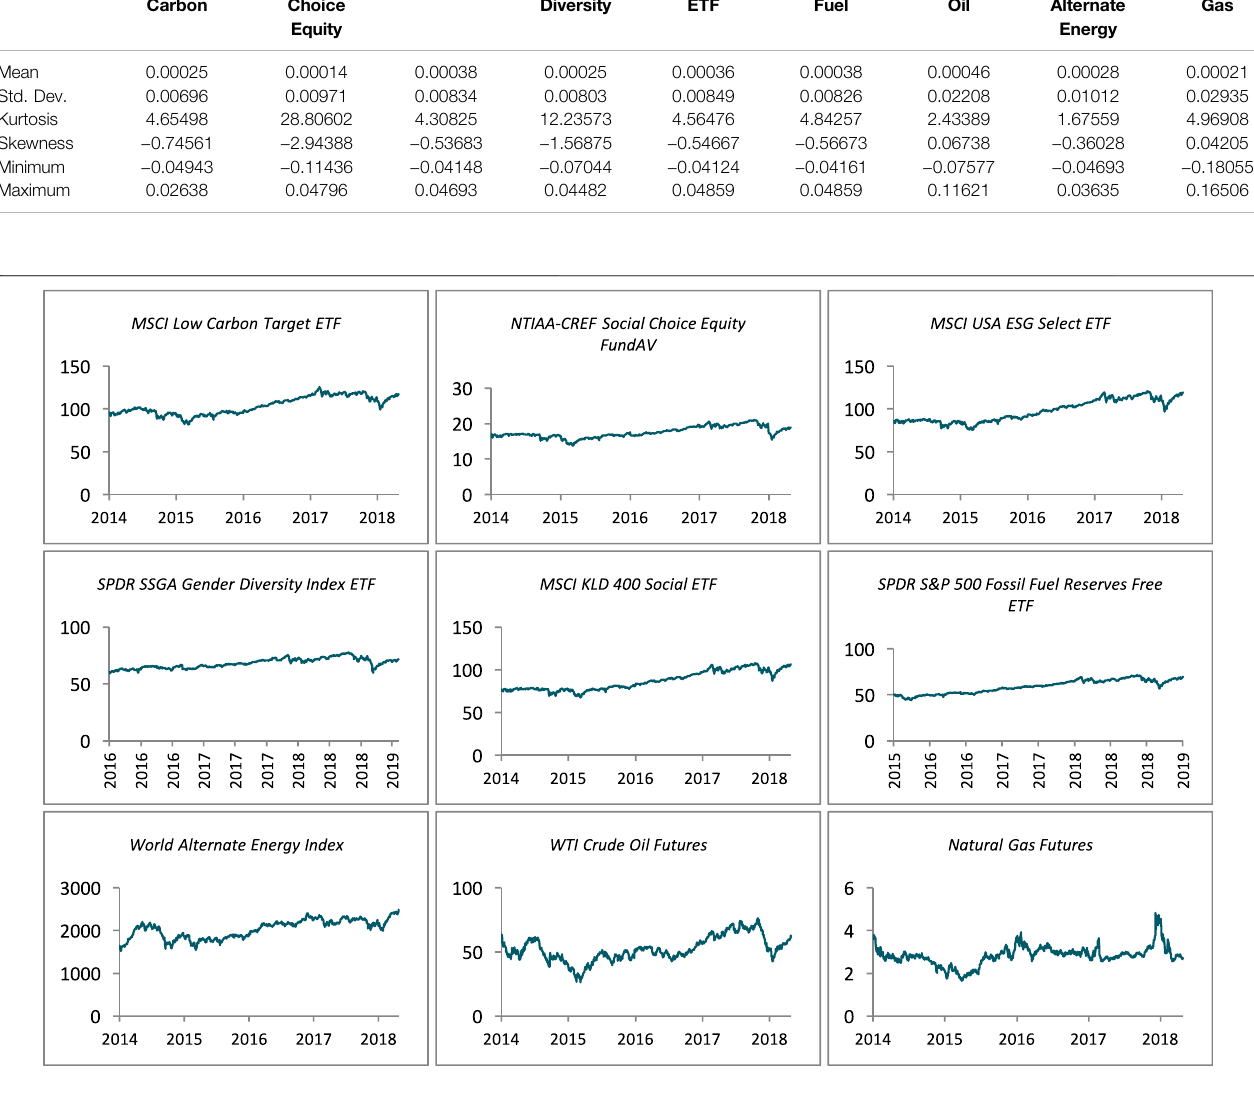
FIGURE 1 | Pricing